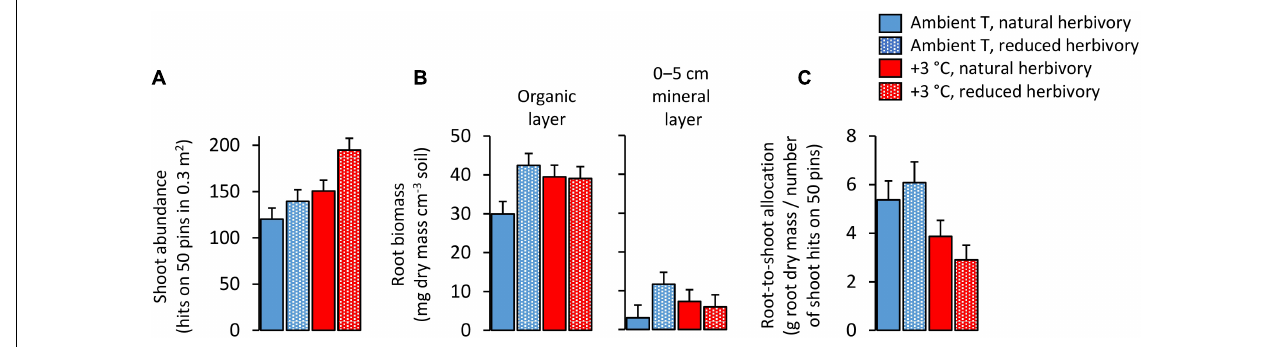
FIGURE 1 | (A) Total vascular plant shoot abundance, (B) root biomass and (C) root-to-shoot allocation in Subarctic field layer vegetation growing in ambient or +3 ◦ C temperature and with either natural or reduced insect herbivory. The means and errors are estimated marginal means and SE values ( n = 5) produced by the fitted statistical models, and were back-transformed from square root-transformed data for root-to-shoot allocation.